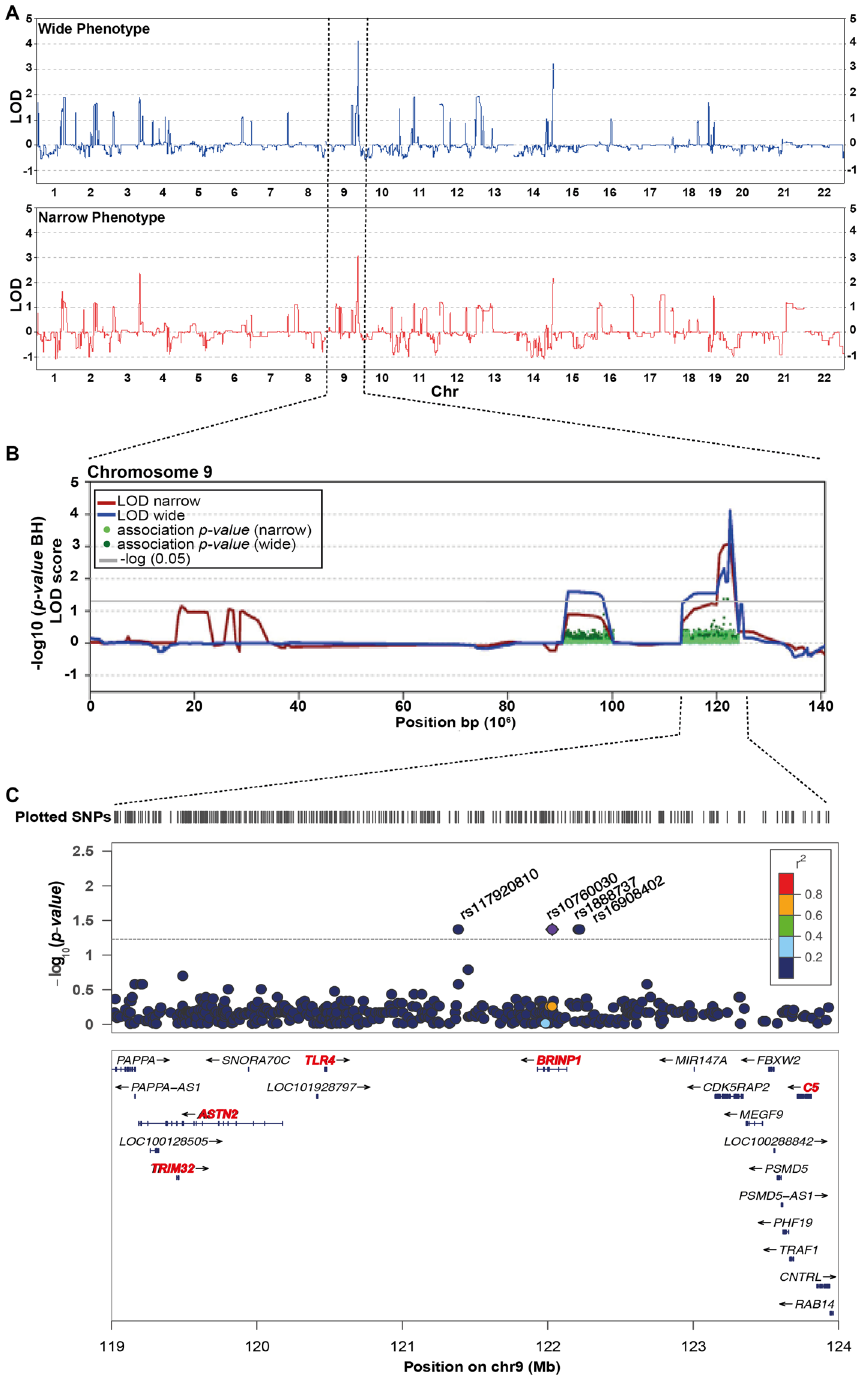
Figure 2. Genome-Wide Linkage Analysis identified the 9q33.1–33.2 linkage region. ( A ) Genome-wide results for the NPL score analysis. In blue represented the LOD scores for the wide phenotype; in red the LOD scores for the narrow phenotype. ( B ) NPL score results for Chromosome 9. The − log10 ( P value) of the family-based association test in regions with significant NPL scores are shown as dark green or light green dots for the wide and narrow phenotype, respectively. ( C ) Regional association plot for the 9q33.1–33.2 linked region. The dashed grey line represents the significance threshold for the associated SNPs. In red, genes previously associated with